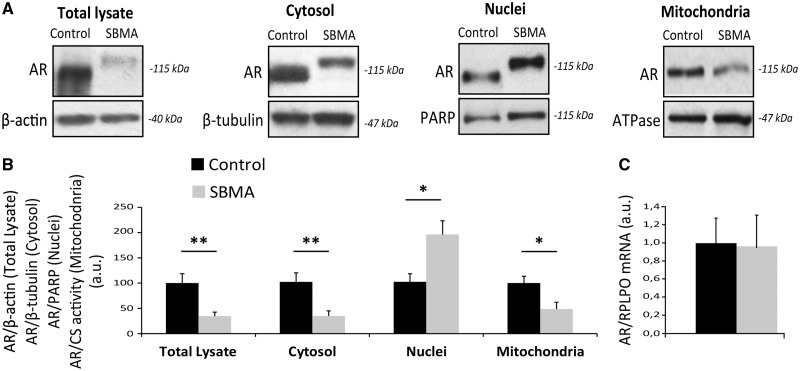
Aberrant subcellular localization of polyglutamine-expanded AR in the muscle of SBMA patients. (A) Western blotting analysis of AR levels in total lysates, cytosolic, nuclear and mitochondrial fractions from quadriceps muscles of SBMA patients and control subjects. β-actin, β-tubulin, PARP and ATPase were used as loading controls. (B) Quantification of AR in total lysates, and nuclear, cytosolic and mitochondrial fractions. Graph, mean ± SEM, n = 7 SBMA patients and 7 control subjects. Poly(ADP-ribose) polymerase (PARP), citrate synthase (CS). Significance by Student’s t test: *P < 0.05, **P < 0.01. (C) Real-time PCR analysis of the AR mRNA transcript levels normalized to large ribosomal protein (RPLPO) mRNA in the muscle of SBMA patients and control individuals. Graph, mean ± SEM, n = 6 SBMA patients and 3 control subjects. Significance by Student’s t test: *P < 0.05, **P < 0.01.